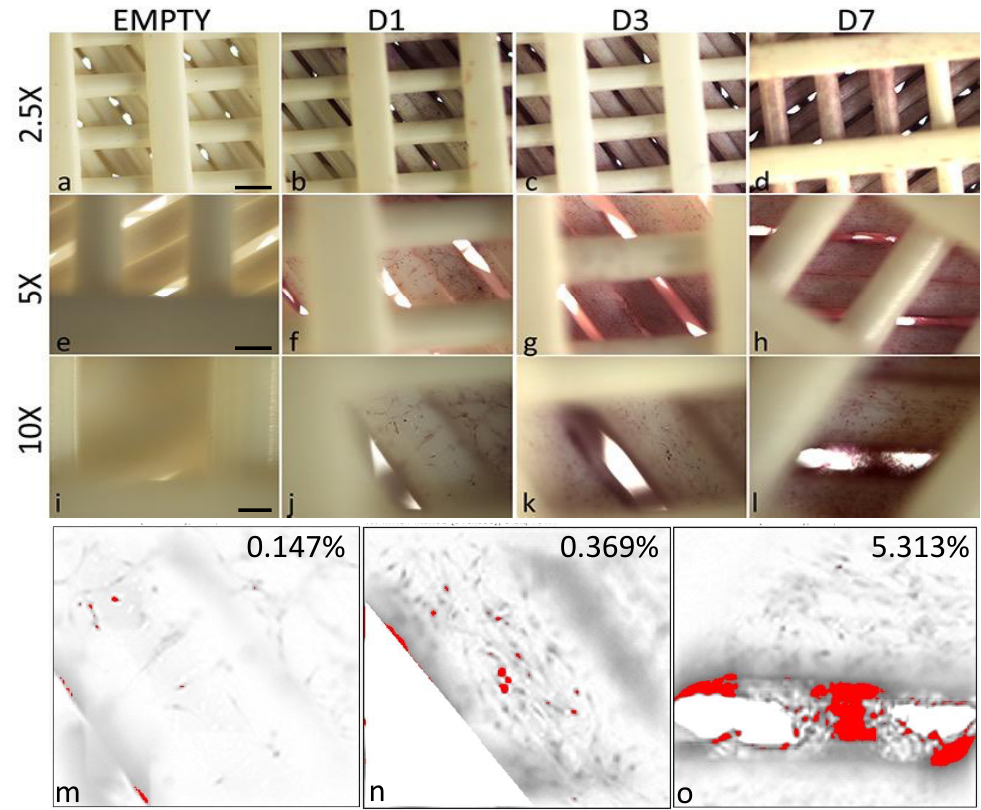
Figure 7. Cell mineralisation analysis of hFOB cells cultured on PLA_PT scaffolds for 1, 3 and 7 days (D1, D3 and D7) by Alizarin Red S staining. Representative images of AR S staining: ( a , e , i ) empty PLA_PT scaffold; ( b – d , f – h , j – l ) hFOB cells cultured on PLA_PT scaffolds for D1, D3 and D7, respectively; ( m – o ) AR S intensity quantification is reported as % area = percentage of pixels in the image highlighted in red using ImageJ threshold. Scale bar 200 mm ( a – d ), 100 mm ( e – h ), 50 mm ( i – l ).